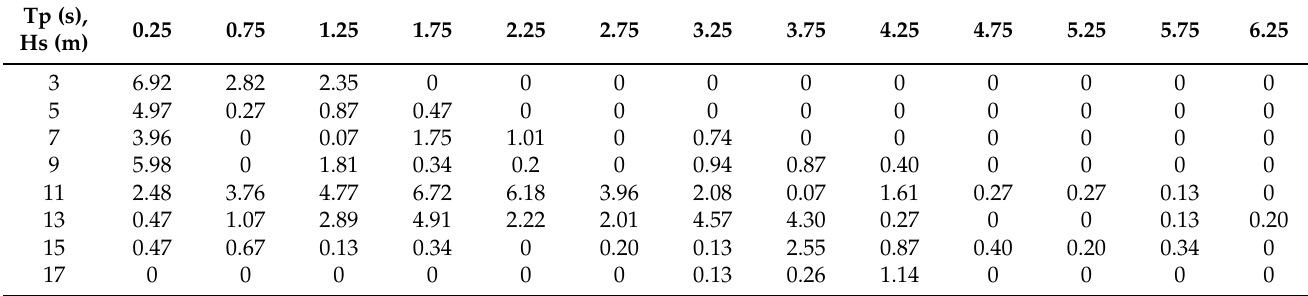
Table A2. Probability density (%) of waves according to significant wave heights (Hs) and peak time periods (Tp) for May 2009 at Orkney [2]. Tp